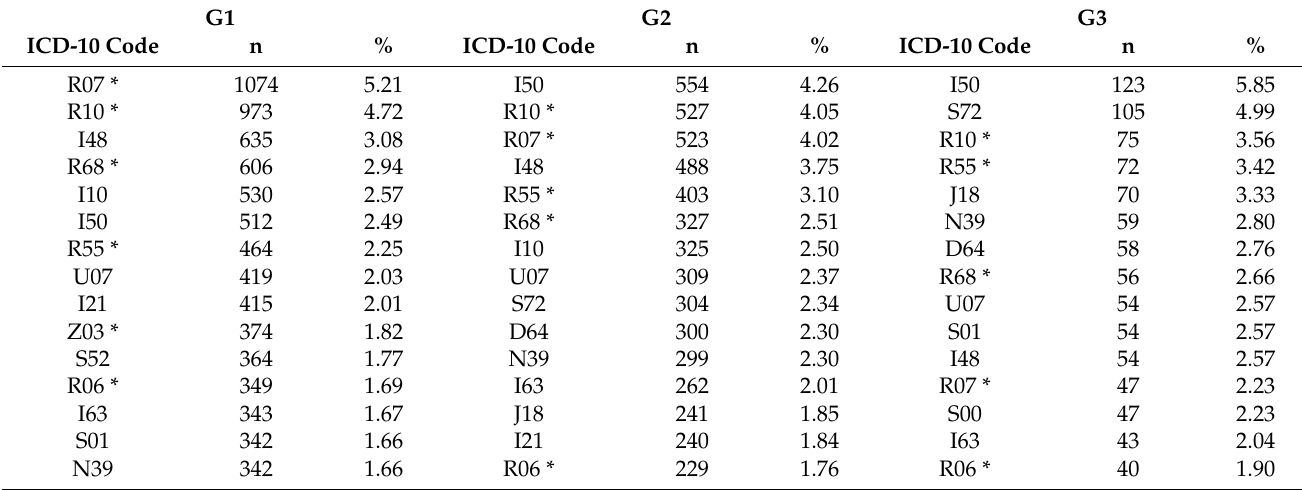
Table 3. Most common diagnoses in each subgroup. Nonspecific diagnoses are marked with asterix. G1—elderly age; G2—senile age; G3—long-livers; D64—Other anemias; I10—Essential (primary) hypertension; I21—Acute myocardial infarction; I48—Atrial fibrillation and flutter; I50—Heart